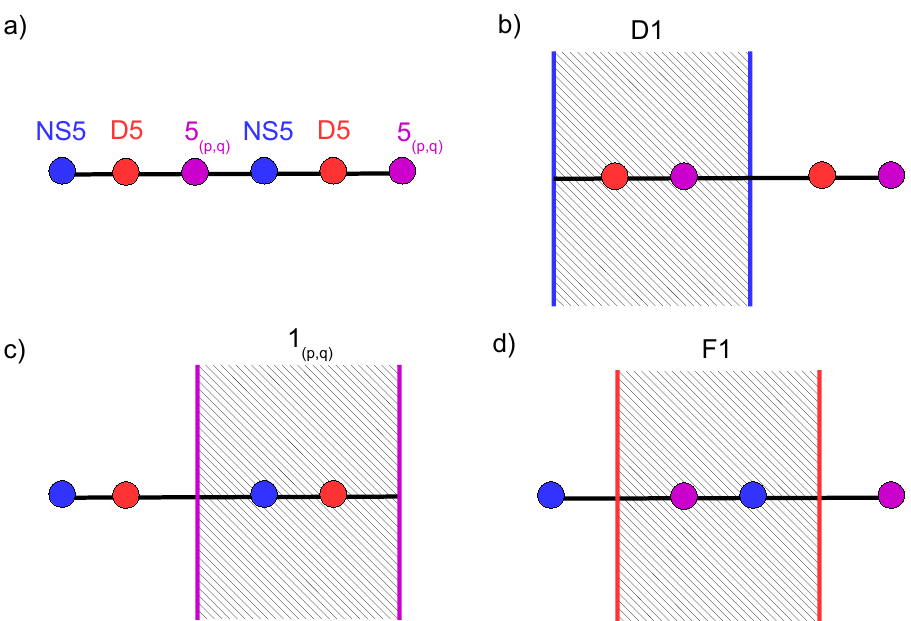
Figure 40 . Brane realization of the T branch I (b), branch II (c) and branch III